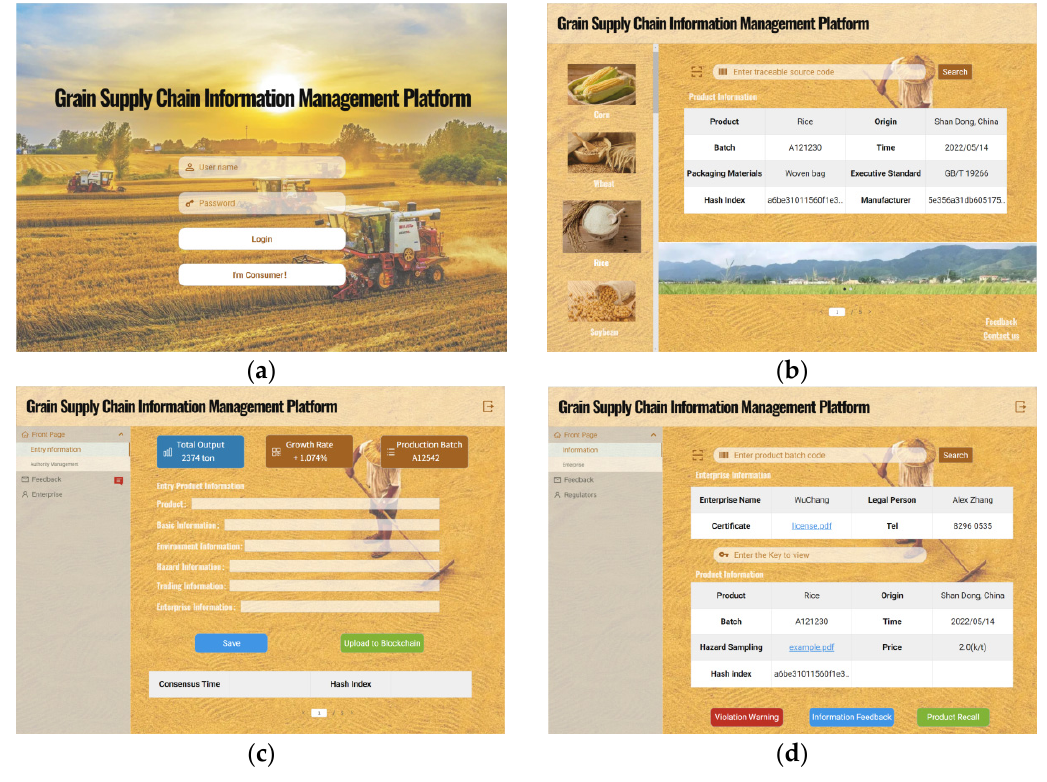
Figure 10. Schematic diagram of the prototype system interface. ( a ) Prototype system login interface; ( b ) consumer traceability interface; ( c ) enterprise information input interface; ( d ) regulatory interface for regulators.